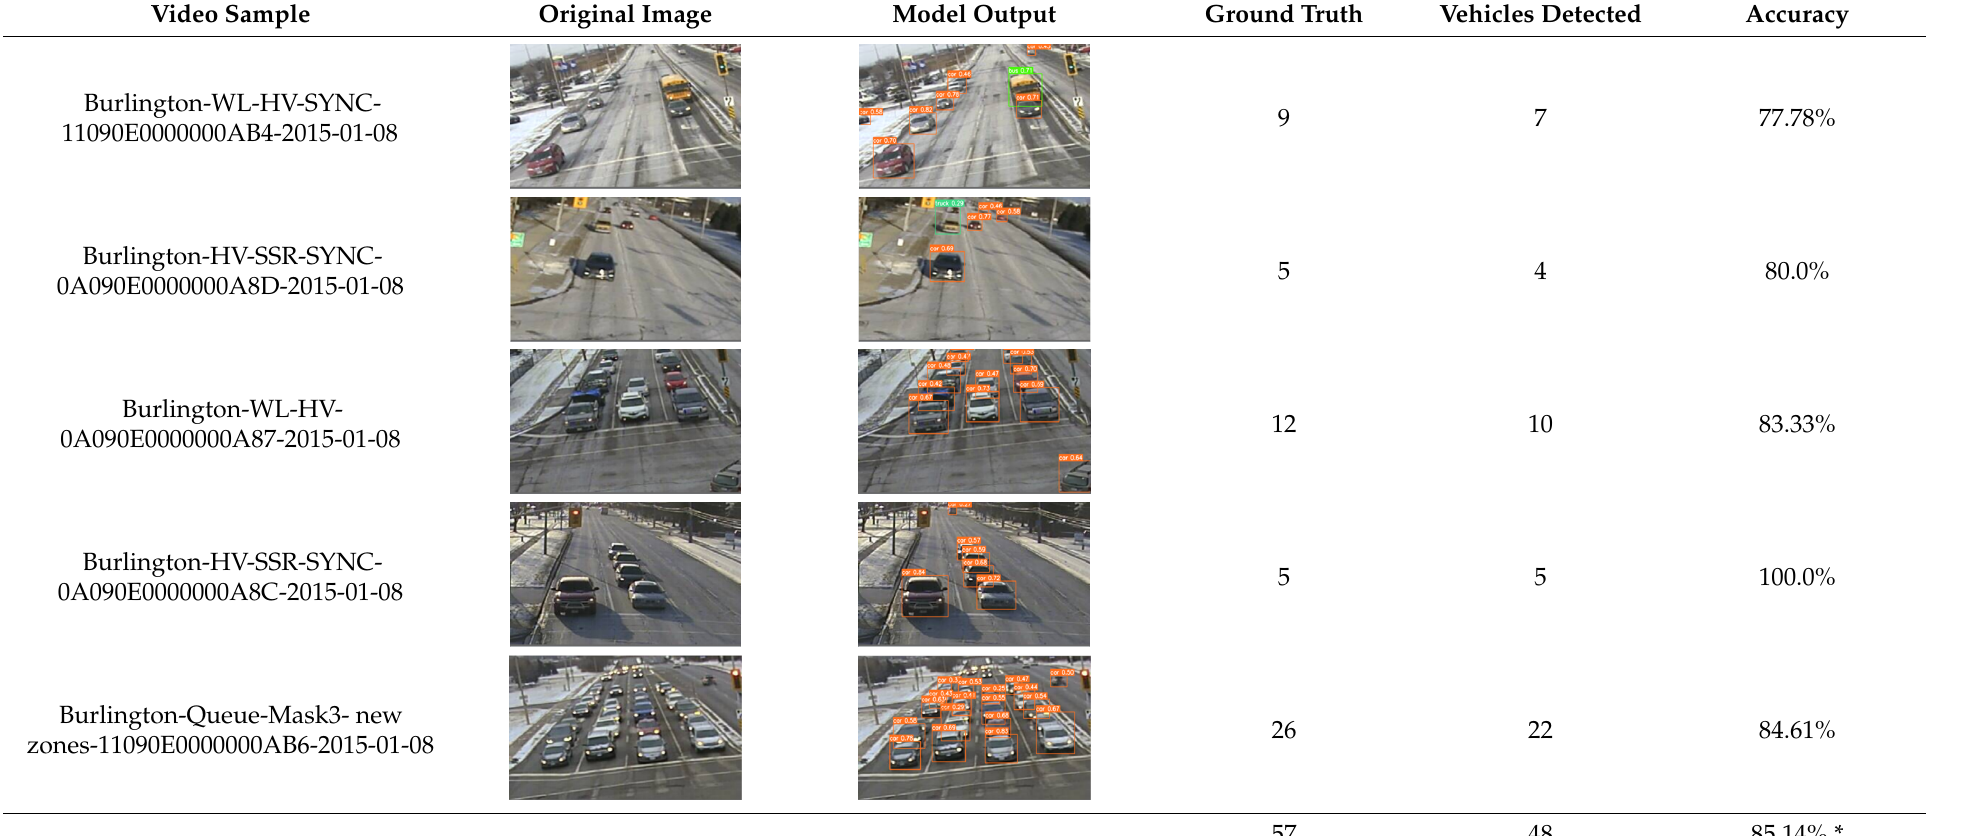
Table A5. Vehicle detection accuracies on selected images obtained from Burlington video using YOLOv5. Cars, buses and trucks marked as orange, neon green and light green colors